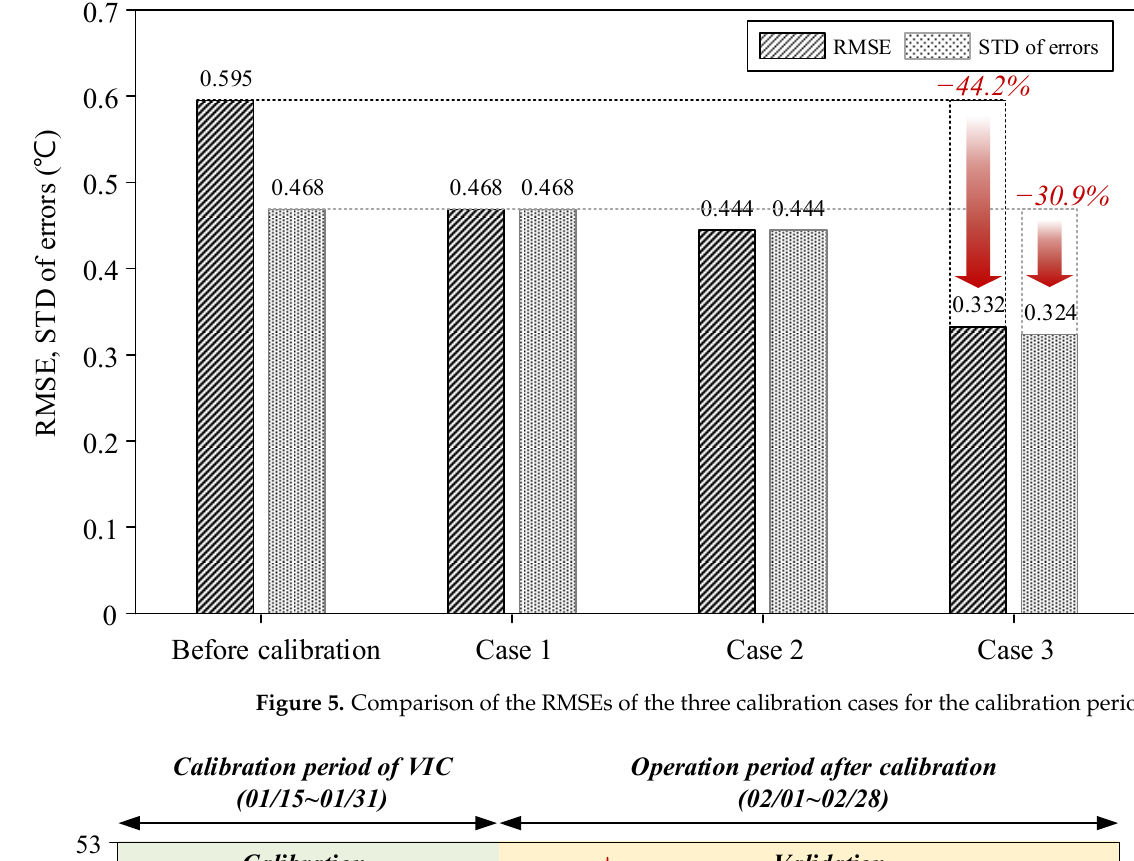
Figure 7. Comparison of virtual sensor performance, displayed according to cases, for the validation period (February 2021). 5. Conclusions In this study, we proposed a VIC method for IBVSs in operational building systems. The case study showed the application results, which highlighted the operational errors of the IBVS, the necessity of calibrating virtual sensors, and the improvements achieved using the proposed calibration method. According to the results of this application, the initial backup virtual sensor for the heating water return temperature had a daily RMSE of 0.97 °C at its worst, and the proposed method seen in Case 3 could provide a lower RMSE of 0.42 °C for the operation after calibration (as seen in February 2021) by correcting the operational uncertainties in a system. It was necessary for VIC to be formulated using the proper correction functions for predicting and offsetting the operational errors. Defining a correction function using a polynomial expression with related system variables is recommended, based on the findings of this study. Using these findings, the recommendation for correction functions and the proposed problem formulation regarding distance functions, correction functions, and Bayesian inference, the VIC for IBVSs can be applied to other operational building systems. This VIC for virtual sensors